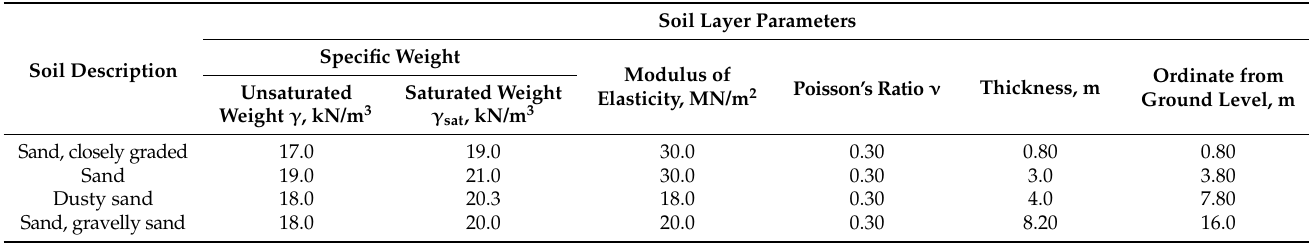
Table 3. Soil materials of soil type I.